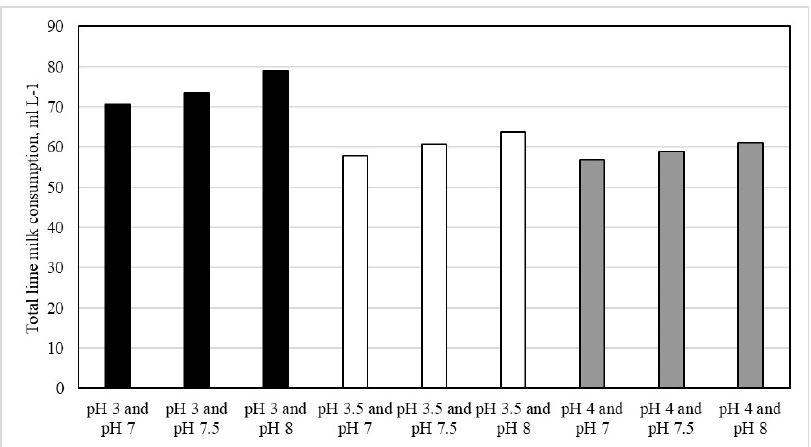
Figure 4. Total lime milk consumption during two neutralization steps of real AMD from the Robule Lake.